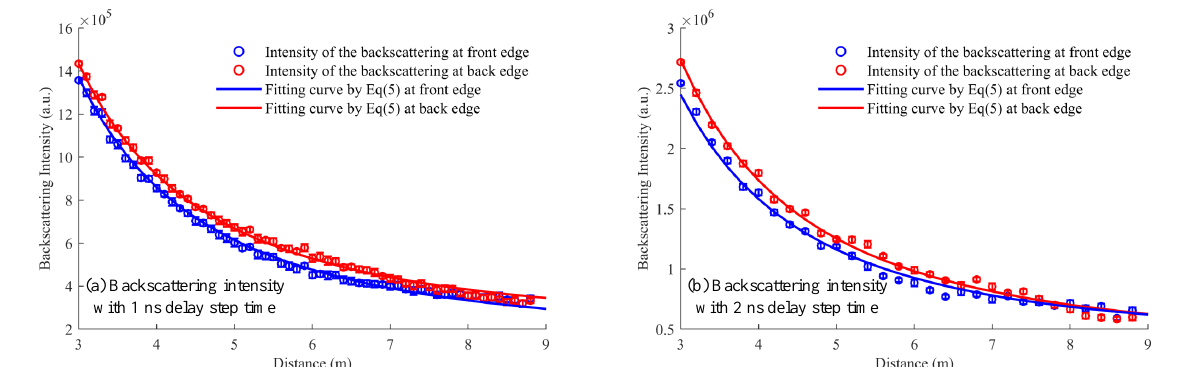
Figure 6. Averaged five measurements of backscattering intensity at 3–9 m in the water body obtained by the front and back edges of the range-gate with different delay step times. ( a ) the delay step time is 1 ns and ( b ) the delay step time is 2 ns.